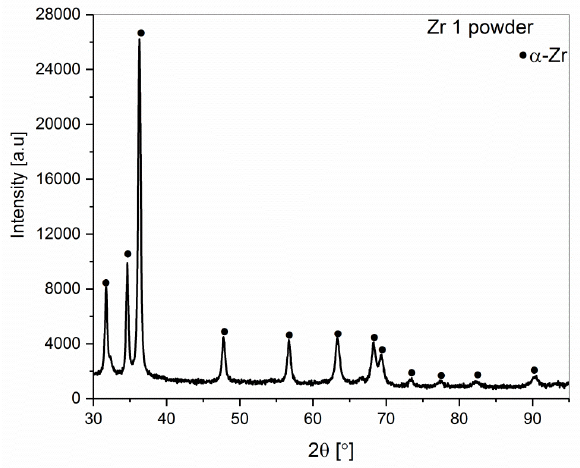
Figure 2. The XRD pattern of the Zr 1 powder (99.9% purity).